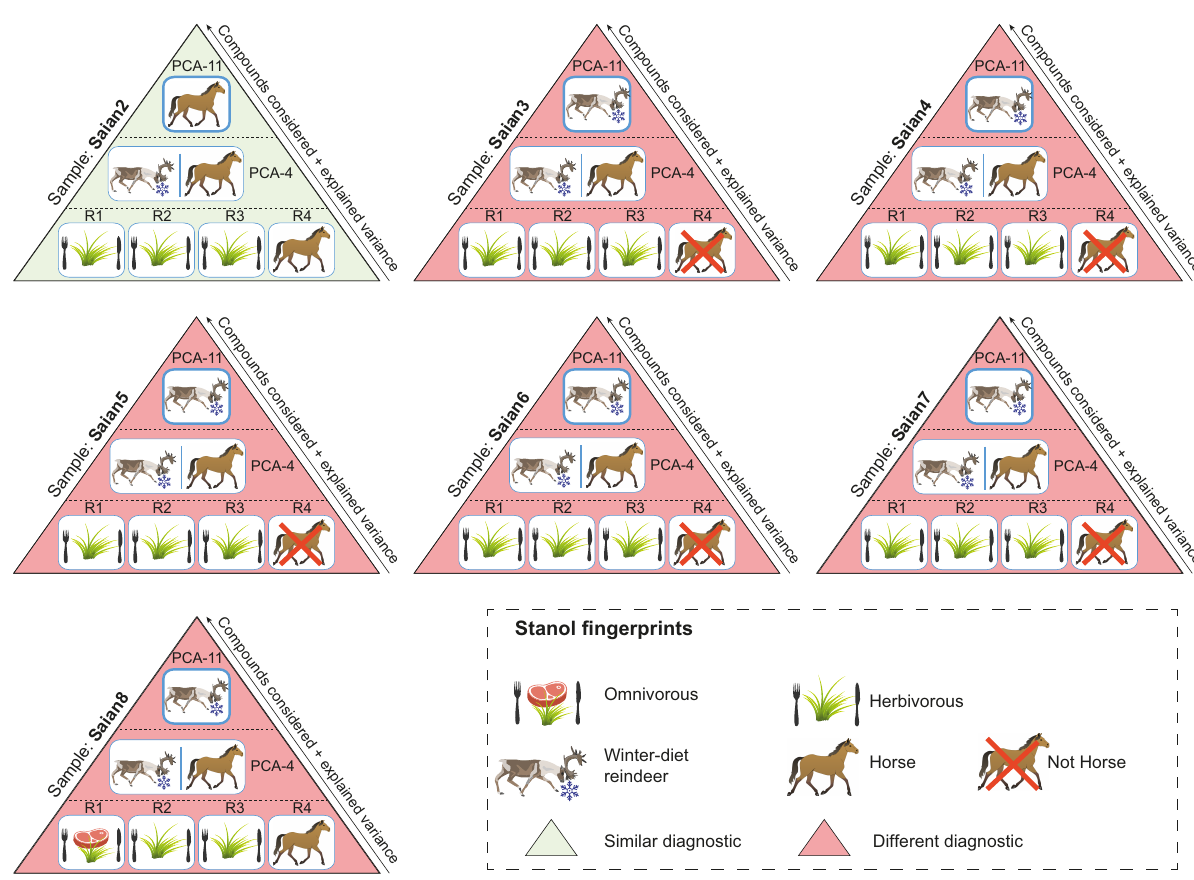
Fig 5. Summary comparison of diet and species identification using ratios and multivariate analyses for soil samples taken from the Tofa site (Sai ͡ an Mountains). More details are presented in S7 Table. R1 refers to the ratio of distributions of coprostanol/(coprostanol + 24-ethylcoprostanol) used to discriminate the herbivore fingerprint from human (herbivore = 0.38 < R1 < 0.73 = human, [20]). R2 refers to the ratio of distributions of (coprostanol + epicoprostanol)/(24-ethylcoprostanol + 24-ethylepicoprostanol) used to identify the omnivore fingerprint (R2 > 1, [7]). R3 refers to the ratio of distributions of epicoprostanol/(cholestanol + coprostanol) used to discriminate the herbivore fingerprint from human (human = 0.01 < R3 < 0.1 = cattle and horse, [21]). R4 refers to the ratio of distributions of (24-ethylepicoprostanol/24-ethylcoprostanol) + (epicoprostanol/coprostanol) used to discriminate the horse fingerprint from other herbivores (No horse = 0.8 < R4 < 1.2 = horse, [10]). PCA-4 refers to the predictive PCA and its corresponding HCPC built with the distribution of the four main 5 β -stanols (coprostanol, epicoprostanol, 24-ethylcoprostanol and 24-ethylepicoprostanol) in the human, dog, horse and reindeer reference samples from our database. PCA-11 refers to the predictive PCA and its corresponding HCPC built with the distribution of eleven 5 β -stanols in the human, dog, horse and reindeer reference samples from our database. Reindeer and horses are herbivores so diagnostics between ratios and multivariate analyses can be compared. the numerical outputs of the HCPC model run on the eleven 5 β -stanol distribution for all 10 species (Fig 2C, S4 Table): the four main explaining variables used to build the hierarchical tree and clustering species fingerprint are coprostanol > 24-ethylcoprostanol > epicoprostanol > 24-ethylepicoprostanol and then the remaining compounds to a lesser extent. This is in agreement with Derrien et al. [22], who found that the main compounds allowing the faecal distinction between omnivores (pigs and humans) and omnivores (cattle) in their PCA model were coprostanol and 24-ethylcoprosta- nol (and sitostanol). The same trend was noticed by Leeming et al. [19] whose pioneering PCA model, built on the concentration of steroidal compounds (including sterols, stanones, 5 α - and 5 β -stanols) from various species, made it possible to distinguish omnivore signatures (mainly humans and pigs) from herbivore signatures (mainly cattle, sheep and horses). In their model, omnivore faeces contained high concentrations of C steroidal compounds (i.e. 27